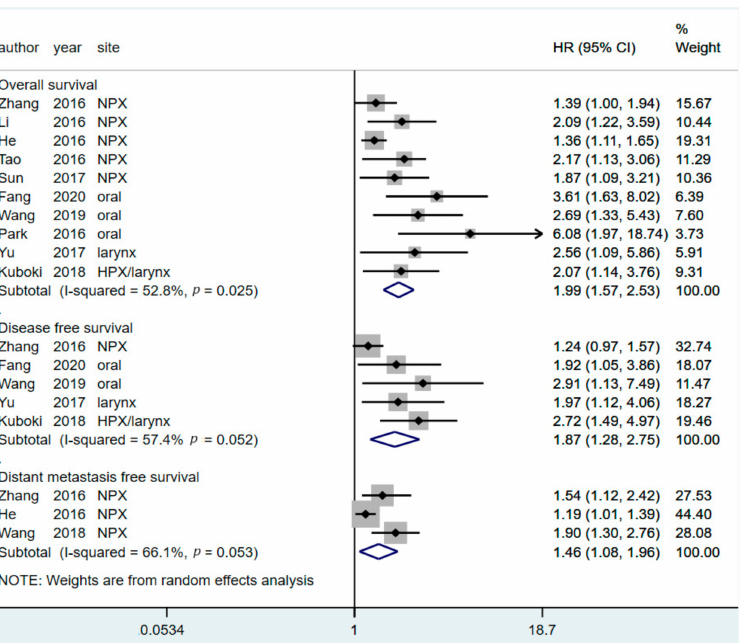
Figure 2. Forest plot showing the hazard ratios of high CARs for predicting overall survival, disease- free survival, and distant metastasis–free survival in patients with head and neck cancer. HR, hazard ratio; CI, confidence interval; CAR, C-reactive protein-to-albumin